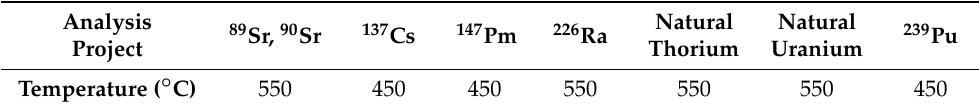
Table 3. Maximum ashing temperature of food samples specified in GB14883-2016.